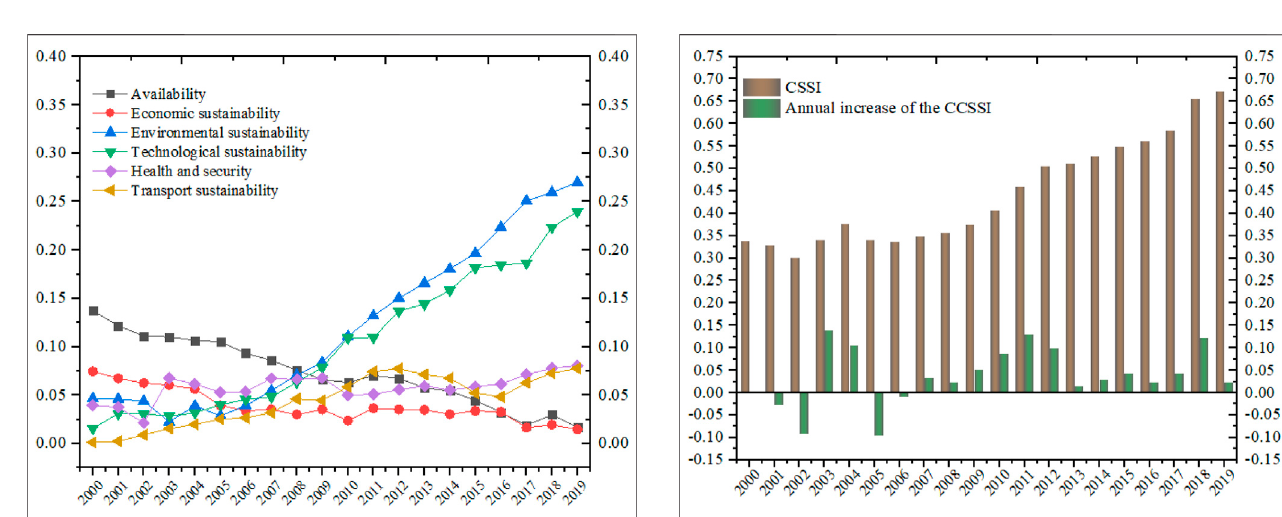
FIGURE 11 | Evolution trend of China ’ s coal supply